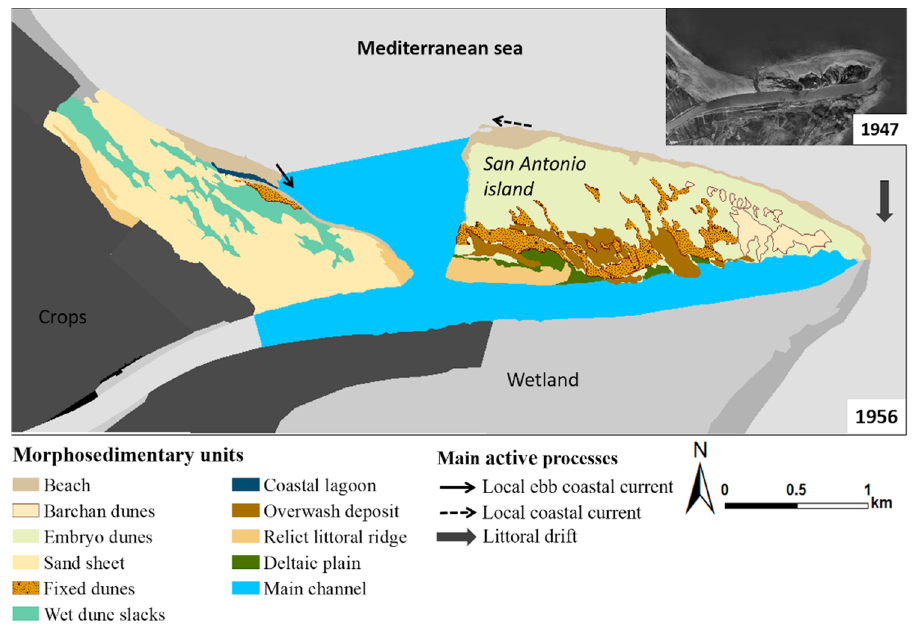
Figure 5. Eco ‐ geomorphological map of the Ebro Delta mouth in 1956. Figure 5. Eco-geomorphological map of the Ebro Delta mouth in